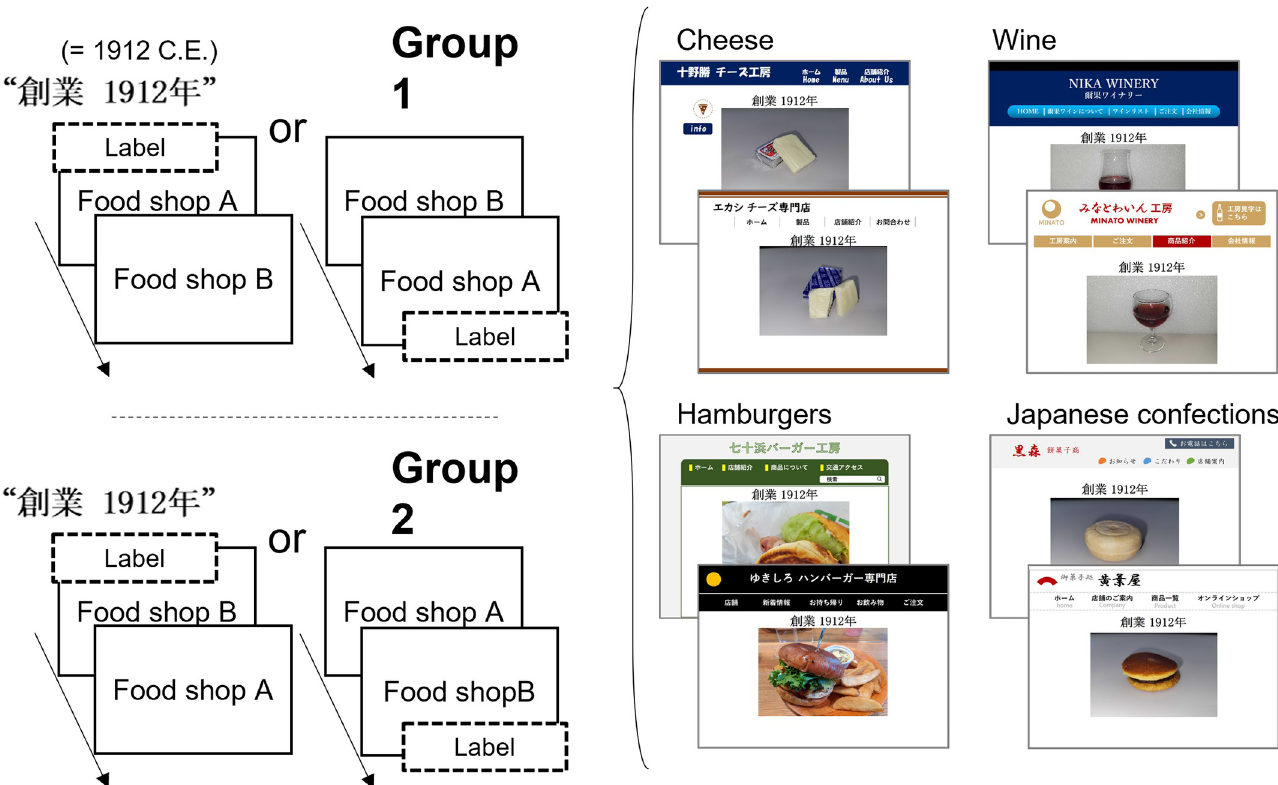
Fig 6. Schematic of a trial sequence from Experiment 3. The label-present and -absent conditions were counterbalanced across participants. A group of participants randomly observed a labeled picture before (or after) observing an unlabeled picture.